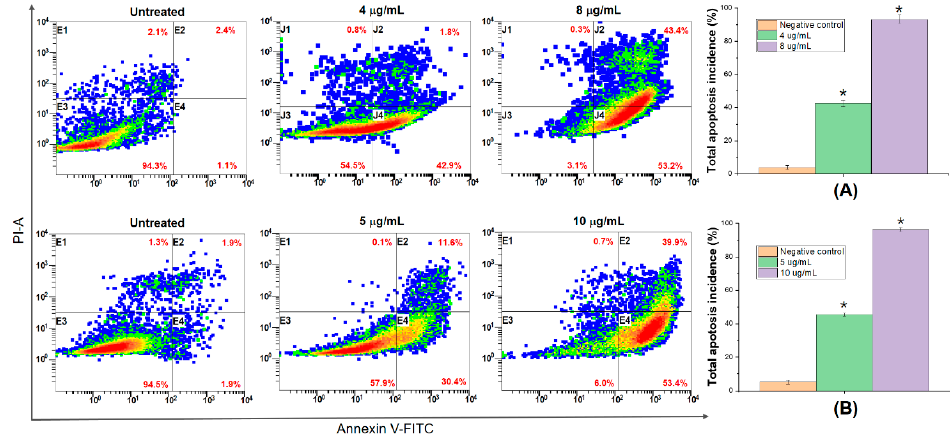
Figure 7. The total percentages of AB2-induced apoptosis in NCI-H460 ( A ) and HepG2 ( B ) cells, *mean significant difference ( p < 0.05) compared to control.